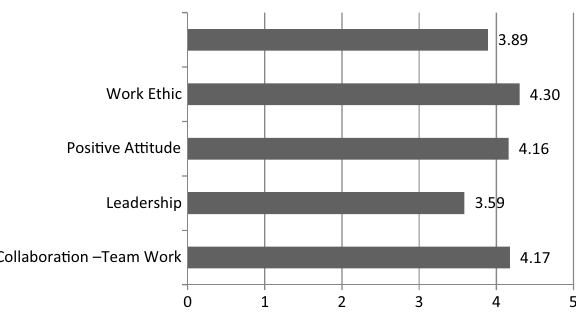
Figure 6: Social competences, overall results. Source: author ’ s own